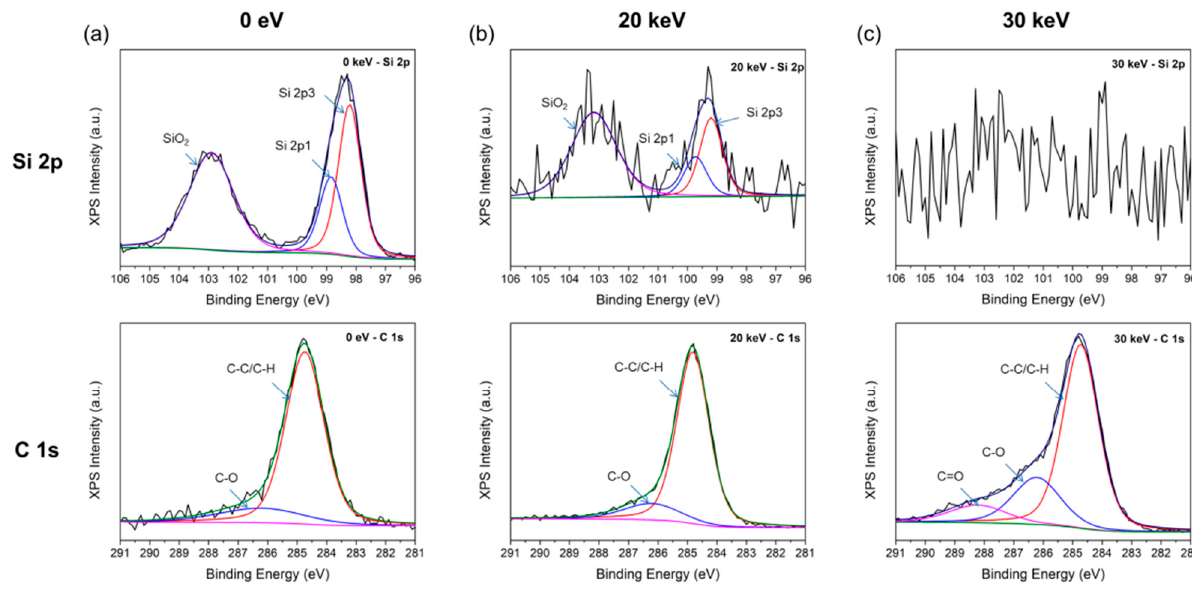
Figure 5. XPS spectra of Si 2p and C 1s states MEMS Si electron lens irradiated with electron beam of ( a ) 0 eV; ( b ) 20 keV; ( c ) 30 keV. (all C-C peaks were calibrated at 284.8 eV in the C 1s XPS spectra)